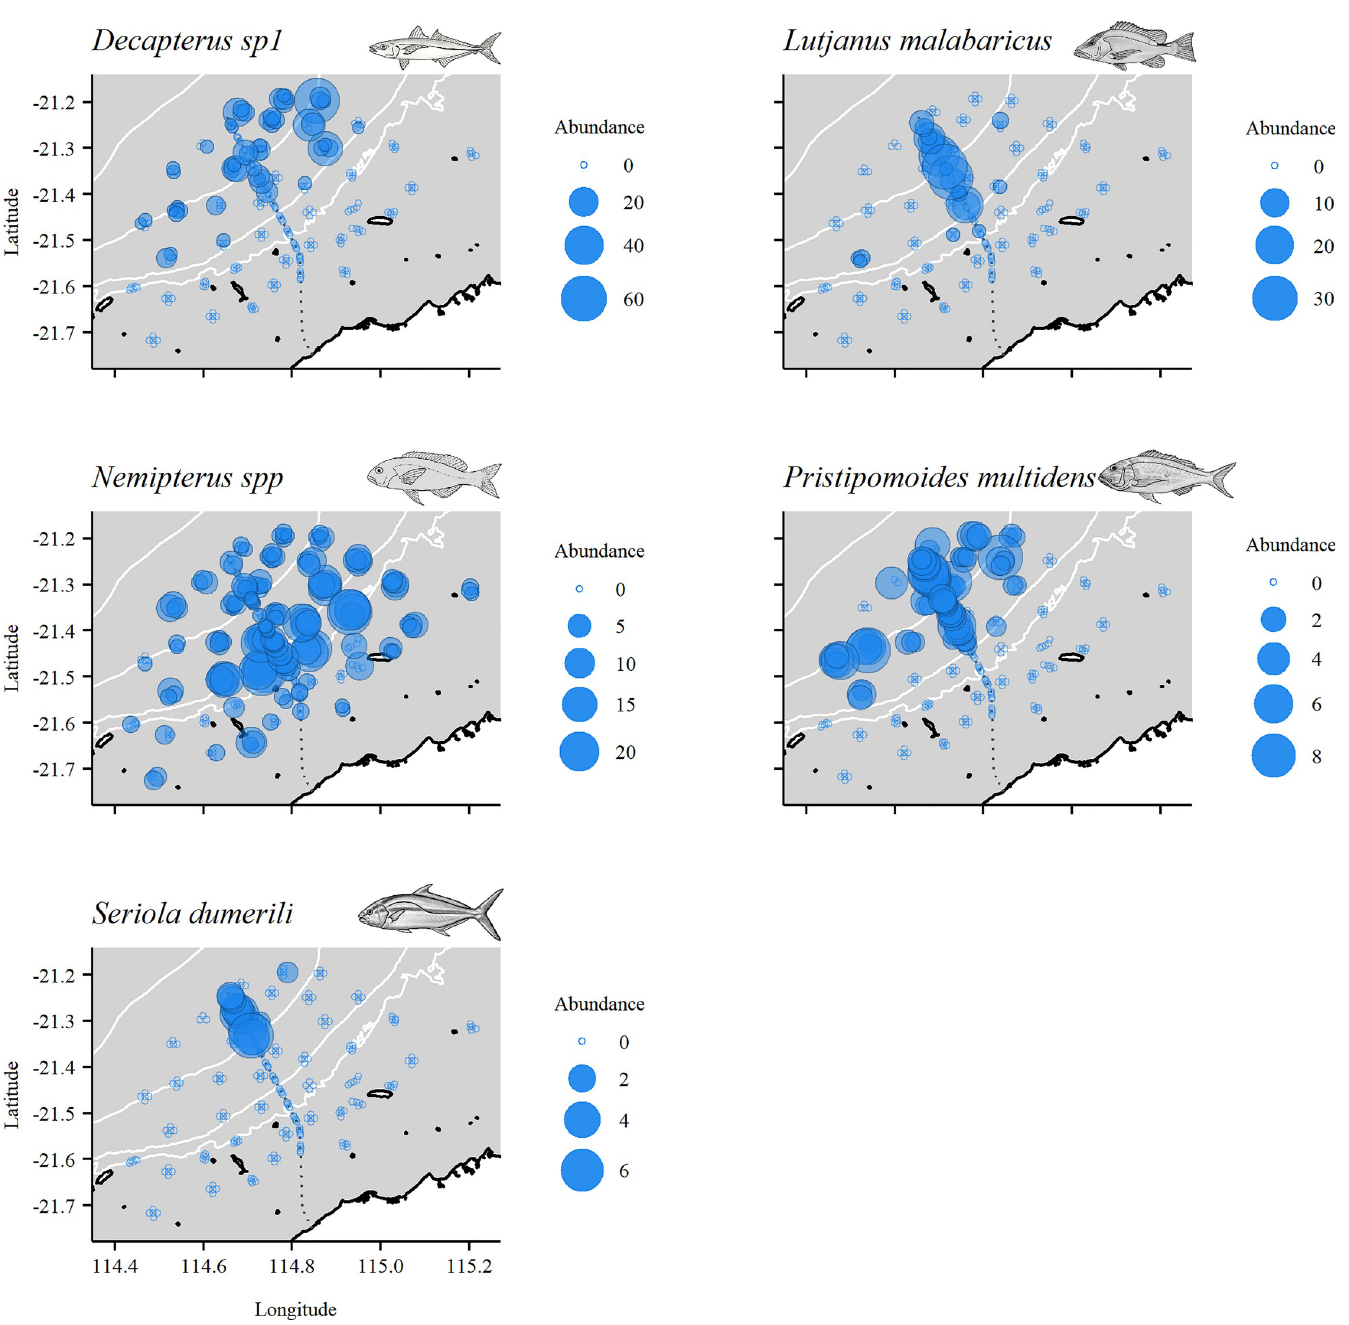
Fig 8. Spatial distribution of the relative abundance of key species in depths > 80 m. MaxN bubble sizes reflect abundance, and therefore bubble size may be larger or smaller than those in the legend.